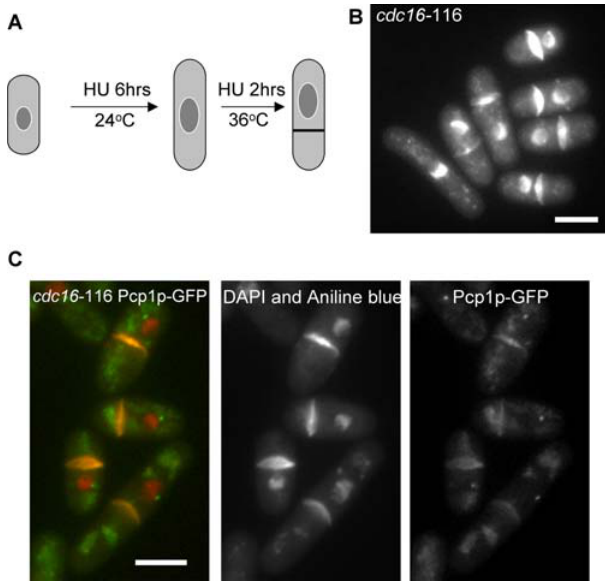
Figure 1. A genetic method to generate anucleate cells. (a) Outline of the strategy to generate anucleate cells. cdc16 -116 mutant cells were treated with HU for 6 hours at 24 u C to arrest cells in interphase. In the presence of HU, cells were shifted to 36 u C to inactive Cdc16p, leading to the formation of septa even when the cells were in interphase. The formation of septa divides the cells into two compartments, one of which lacks a nucleus. (b) cdc16 -116 mutant cells, treated with HU as described above, were fixed and stained with DAPI and aniline blue to visualize nuclei and septa, respectively. Shown are the un-cleaved septa formed in interphase cells dividing the cell into two compartments, one of which lacks a nucleus. (c) Anucleate cells do not contain SPBs. cdc16 - 116 cells expressing Pcp1p-GFP were shifted to the restrictive temperature in the presence of HU, fixed and stained with DAPI and aniline blue to visualize nuclei and septa, respectively. Pcp1p-GFP (green) is associated with nuclei (red) and is not observed in anucleate compartments. Scale, 5 m